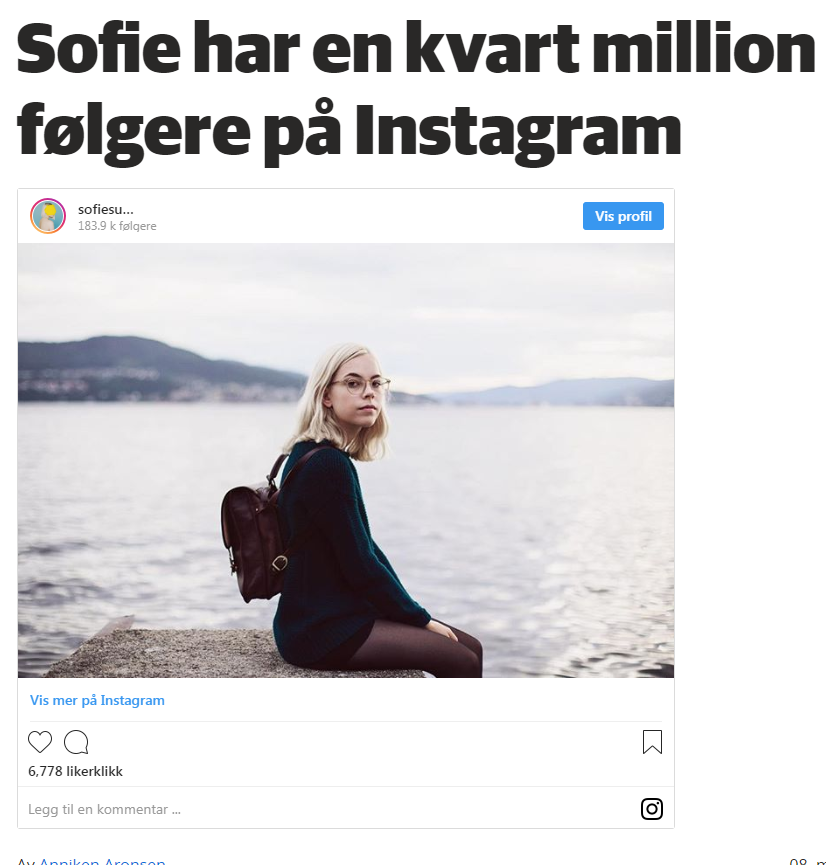
Figure 4. Media: locals mimicking the style of influencers.